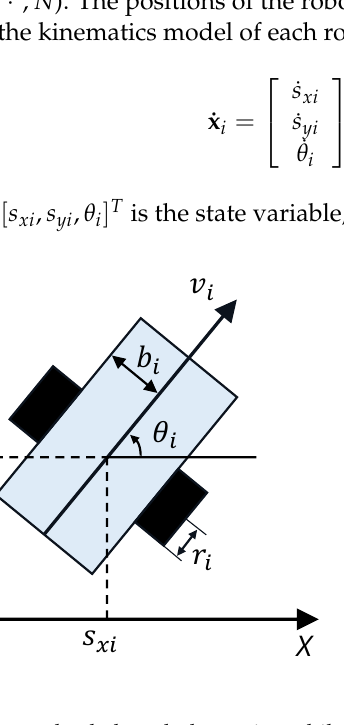
Figure 1. A two-wheeled nonholonomic mobile